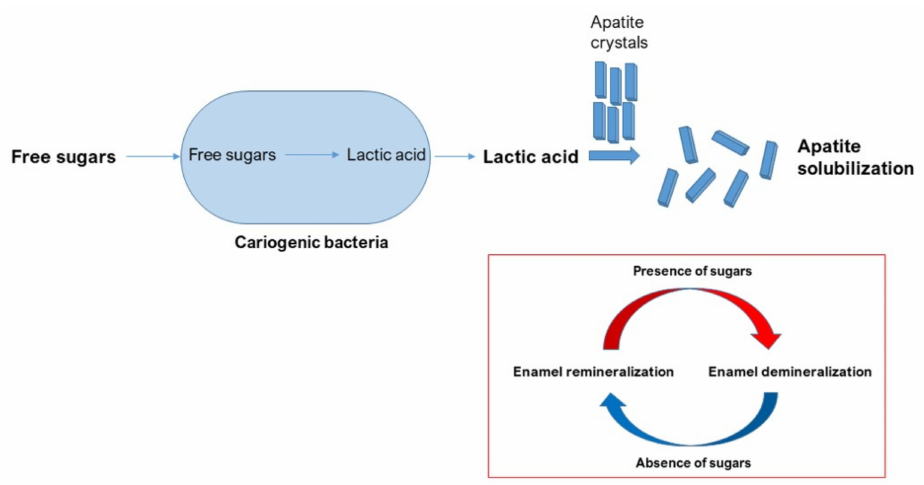
Figure 2. The process of caries